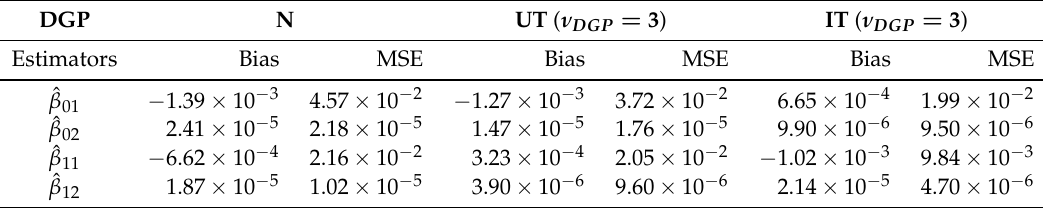
Table 3. Bias and MSE of the maximum likelihood estimators of βββ for the corresponding DGP (Gaussian, UT, and IT). DGP N UT ( ν DGP = 3 ) IT ( ν DGP = 3 ) Estimators Bias MSE Bias MSE